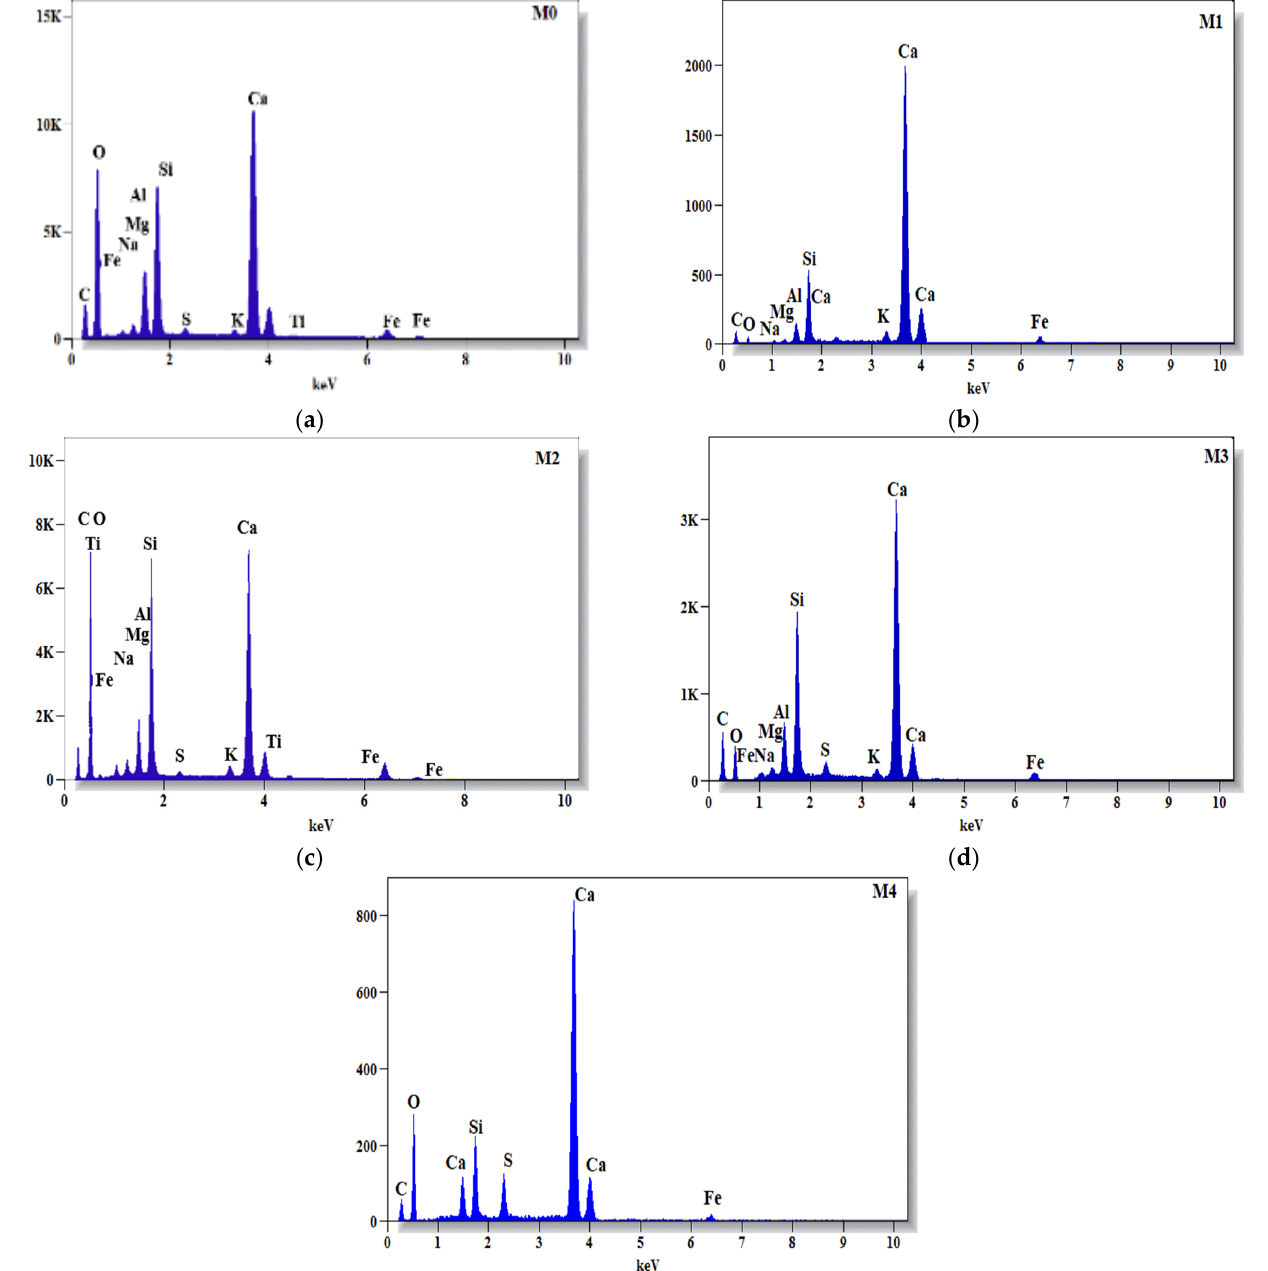
Figure 9. EDS spectrum of BFRFGC for five different mixes. ( a ) M0; ( b ) M1; ( c ) M2; ( d ) M3; ( e ) M4.